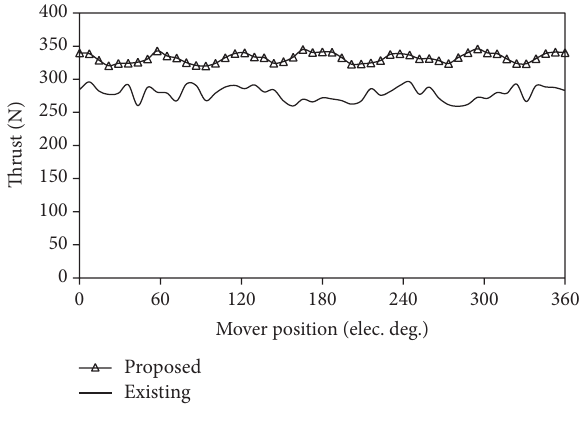
Figure 17: Comparison of thrusts.